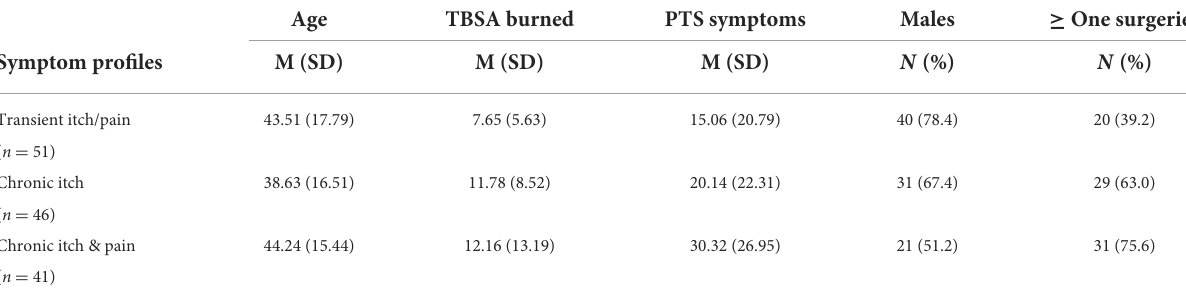
TABLE 1 Descriptive details of predictors for the different itch profiles. Age TBSA burned PTS symptoms Males ≥ One